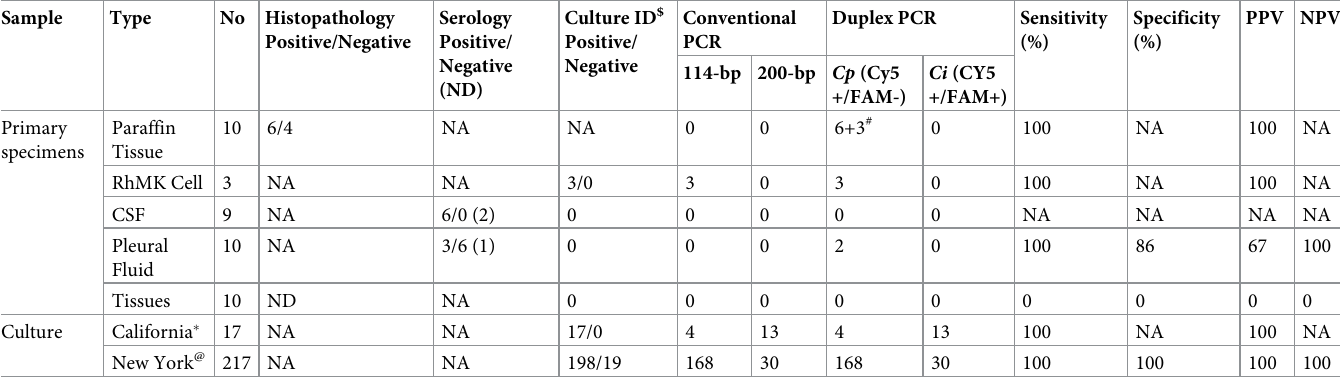
Table 1. Results of histopathology, serology, culture, conventional and duplex